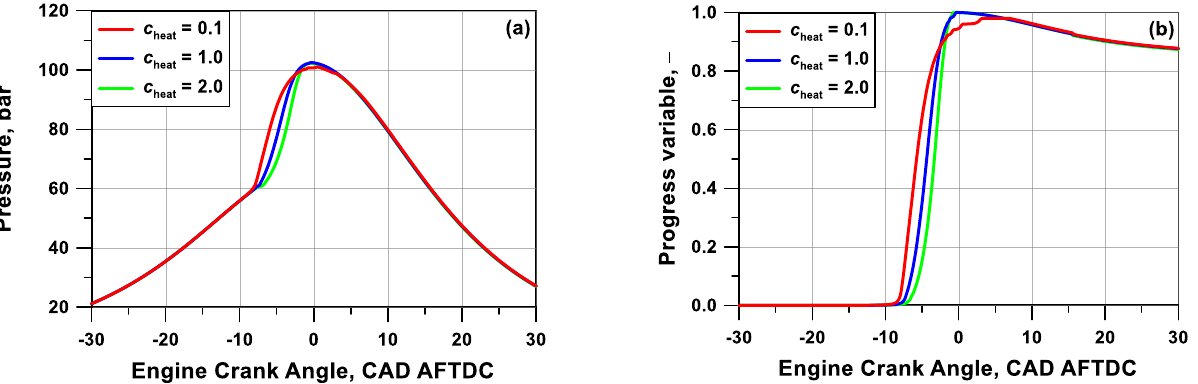
Figure 7. Pressure cycles ( a ) and progress variable ( b ) of Case #6 as a function of the heat fraction distribution profile.